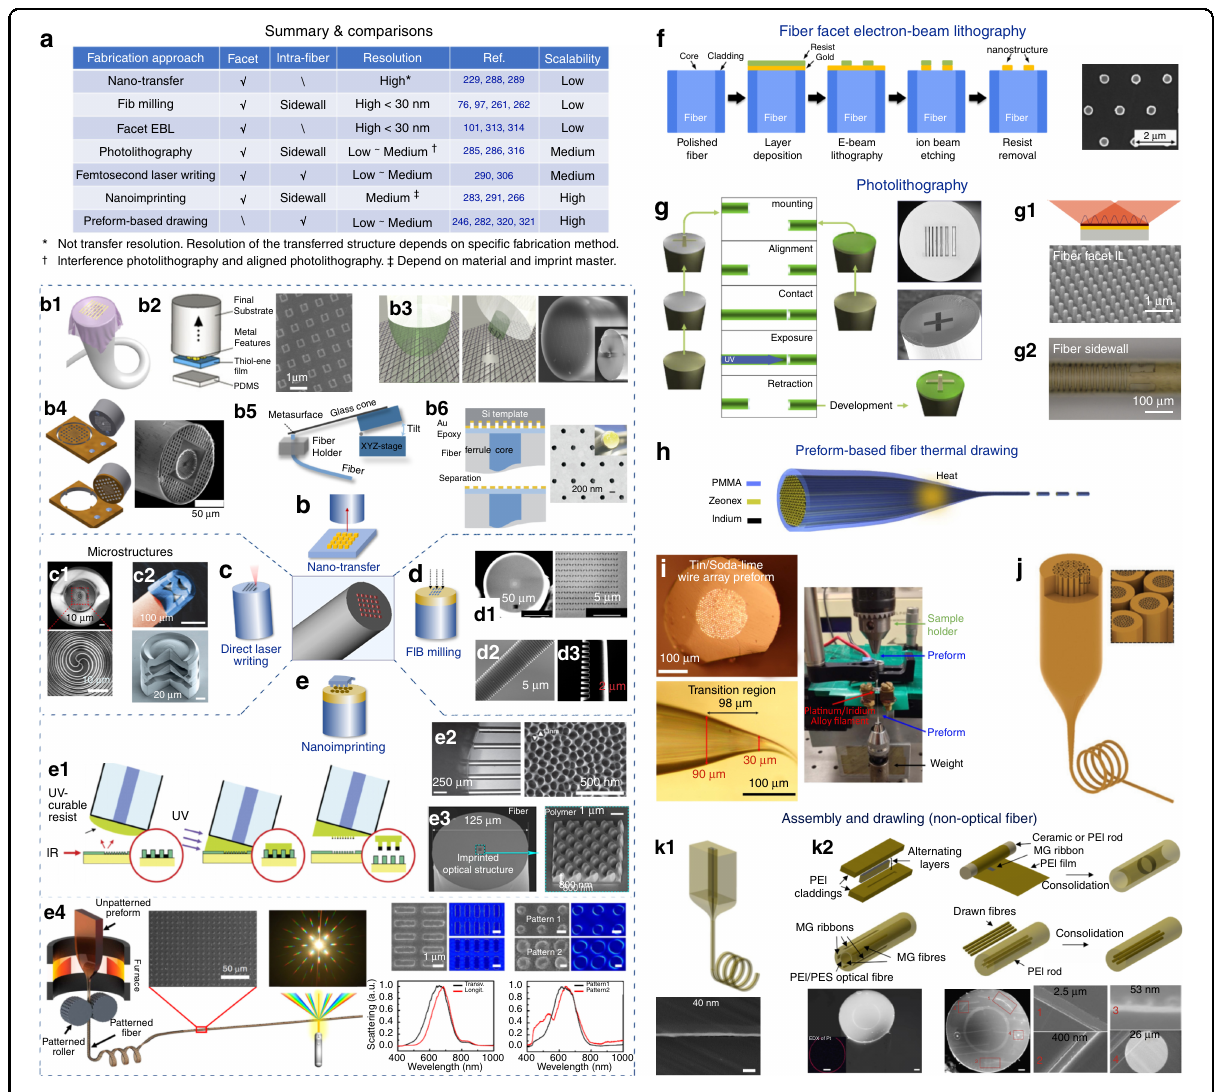
Fig. 7 Fabrication technologies for meta-structured fi bers. a Summary of different fi ber fabrication methods 76,229,283,287 – 294 . b Nanotransfer. b 1 Wet-transferred gold nanoslit grating membrane on a fi ber facet 288 . b 2 ‘ Decal transfer ’ schematics 296 and SEM image of the transferred structure. b 3 Template stripping transfer via UV-curable polymer (green hemisphere) on fi ber tip 289 . b 4 Mounting technique 103 . b 5 Micromanipulation set-up 299 . b 6 Template transfer method and the fabricated fi ber facet 301 . c Femtosecond laser writing lithography. c 1 Fiber facet-integrated spiral zone plate 290 . c 2 On- fi ber multi-lens objectives and structure details 305 . d FIB milling. d 1 Fabricated plasmonic fi ber meta-tip 76 . d 2 SEM image of a tapered fi ber U-grooves for fi ber array alignment and the imprinted structures 291 . e 3 The imprinted fi ber facet and close-up structure details 311 . e 4 Direct imprinting thermal drawing schematic and resolution test patterns ( e 5) 266 . f Process schematic for EBL on fi ber facet and SEM image of the fabricated structure 101 . g ‘ Align-and-shine ’ photolithography 286 . Insets: fabricated structures. g 1 Interference lithography (IL). Lower panel: Fabricated